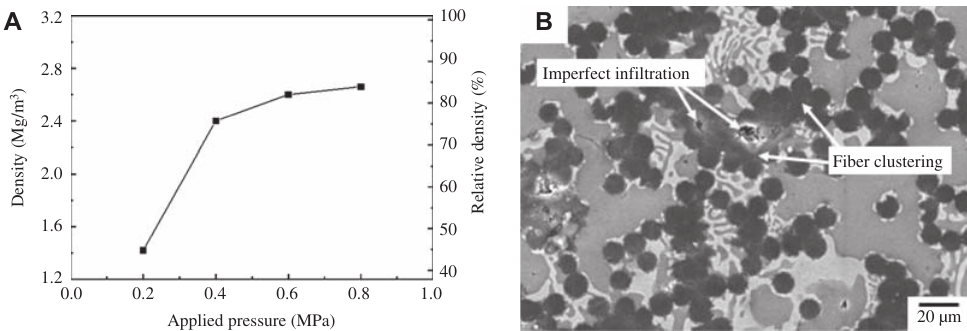
Figure 3 Infl uence of applied infi ltration pressures on CF/Al composites; (A) density variation and (B) microstructure CF/Al composites at 0.8MPa.